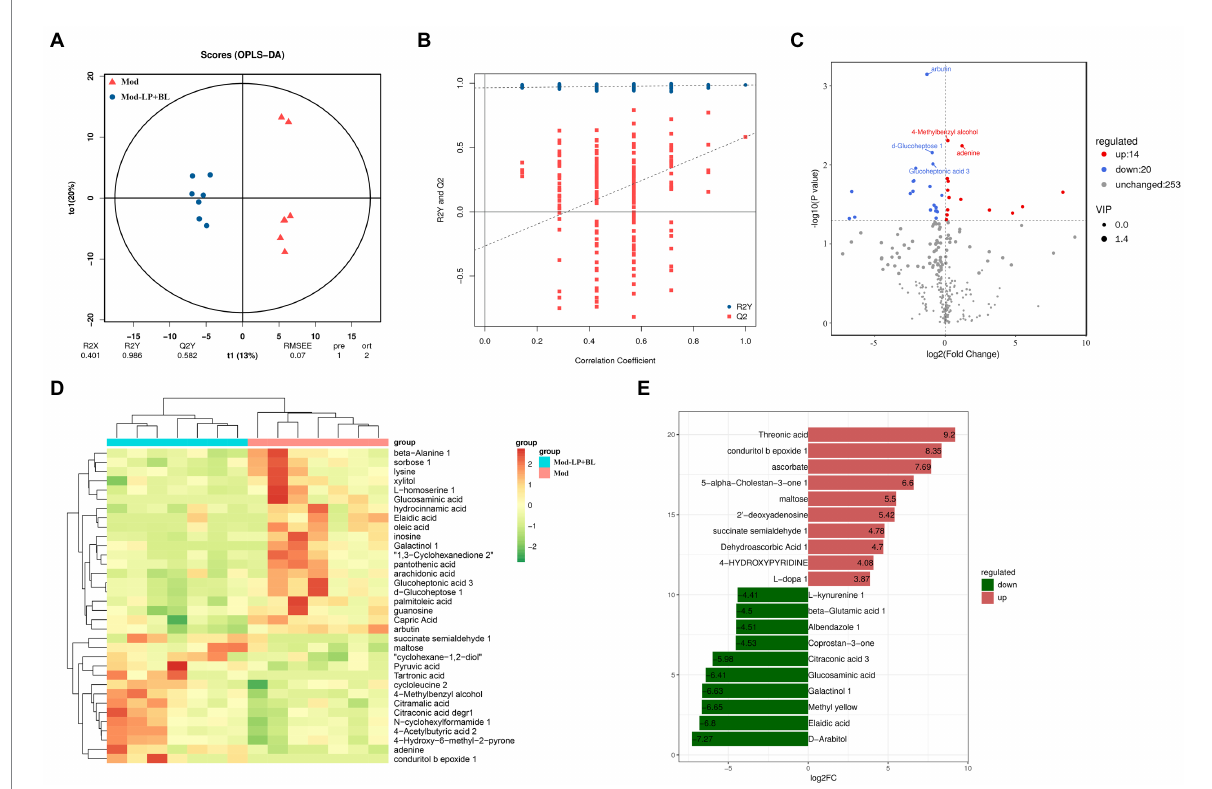
FIGURE 7 Effects of B. lactis and L. plantarum on microbial metabolites in glioma mice. (A) OPLS-DA score plot and (B) permutation tests of OPLS-DA models. (C) Differential fecal metabolites volcano plot of the Mod and Mod-LP + BL groups. (D) Unsupervised hierarchical heatmap of differential fecal metabolites between the Mod and Mod-LP + BL groups. (E) Fold change of differential